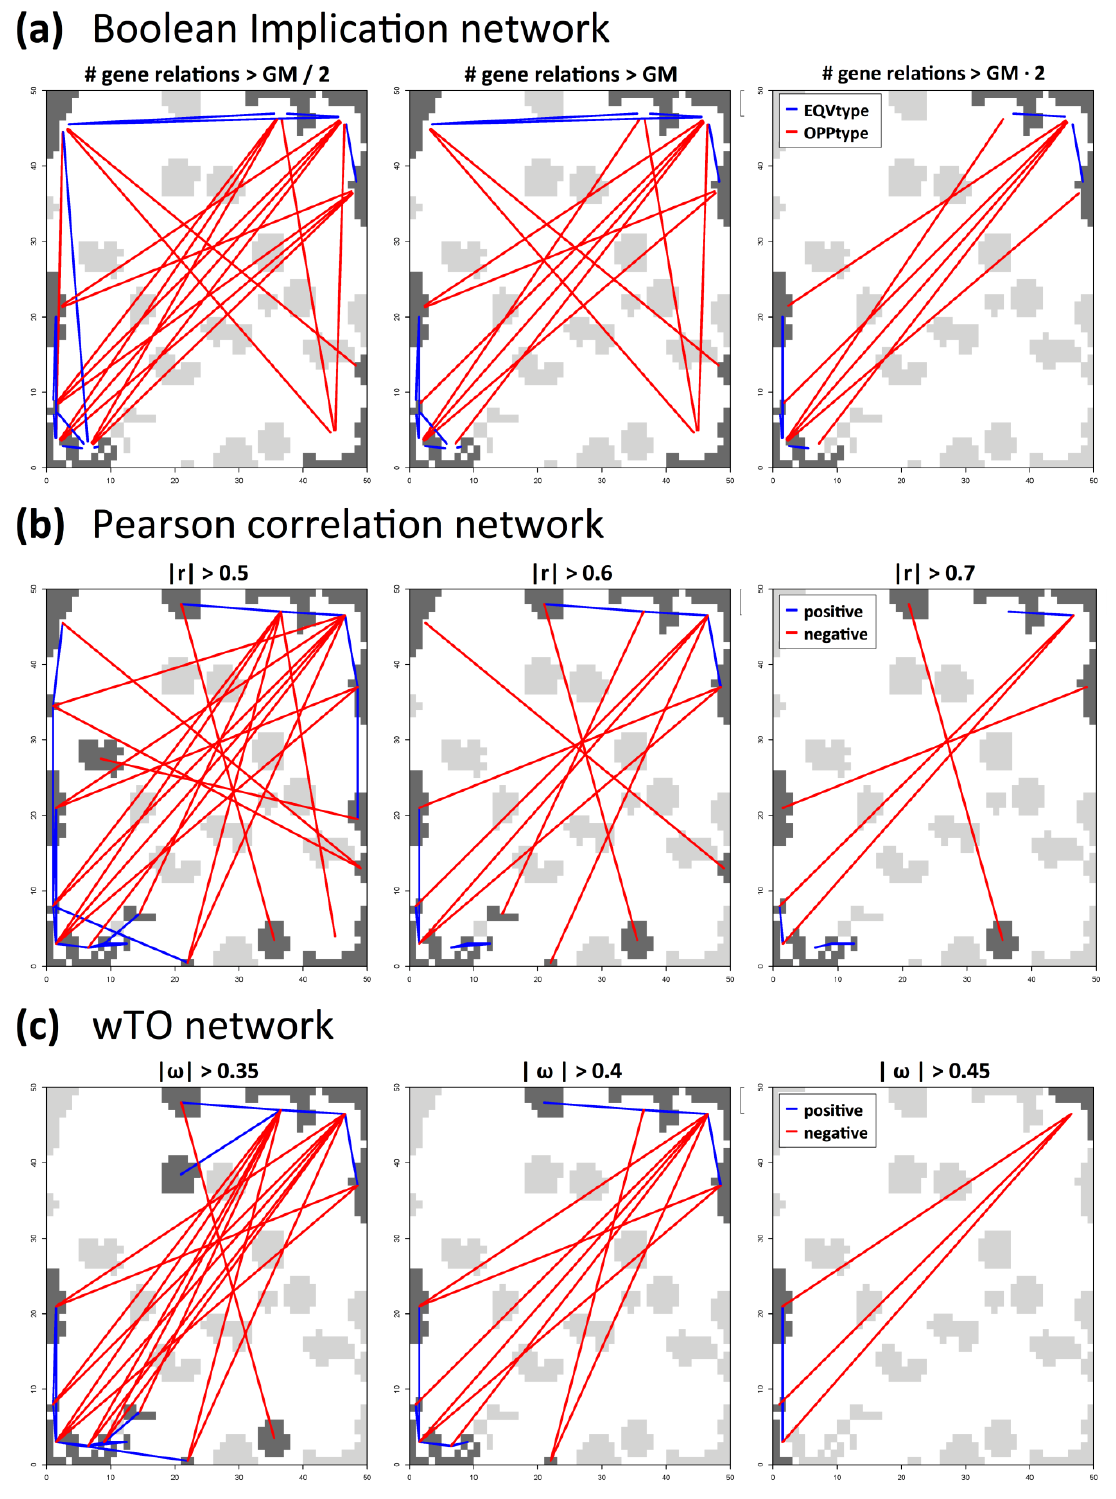
Figure 11: Spot module relations provided by different approaches. Boolean implications derived from gene-level relations with differing filter threshold; GM denotes the geometric mean number of genes in the respective spot pairs (panel a); spot profiles exceeding varying thresholds in Pearson correlation analysis (panel b) and weighted topological (wTO) analysis (panel c),